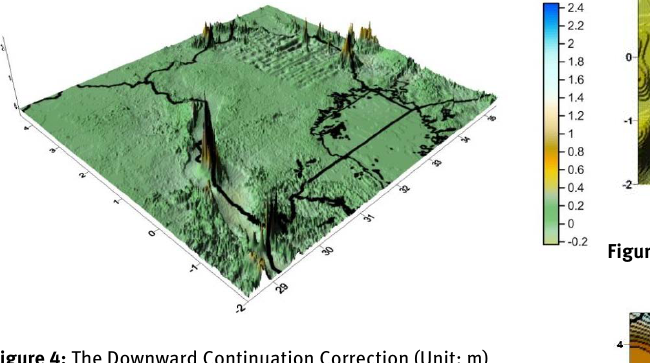
Figure 4: The Downward Continuation Correction (Unit: m)